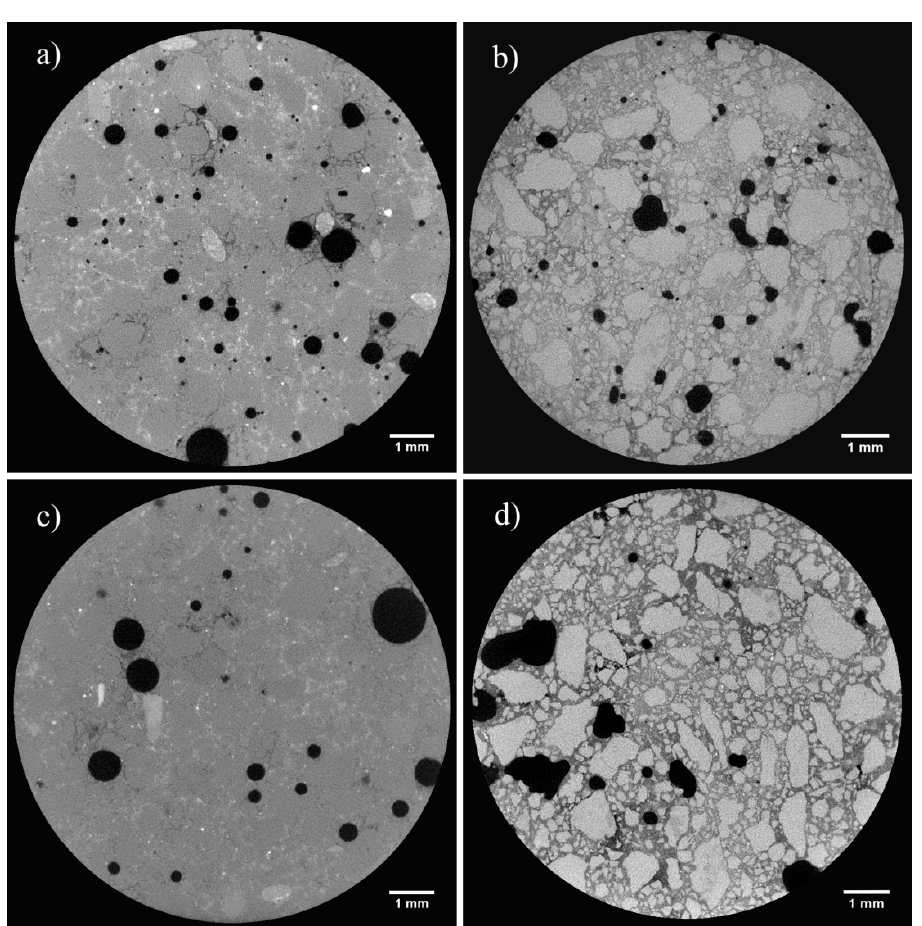
Figure 6. Slices of X-ray tomography of samples ( a ) CIQ, ( b ) CIM, ( c ) CIVQ and ( d ) CIVM.